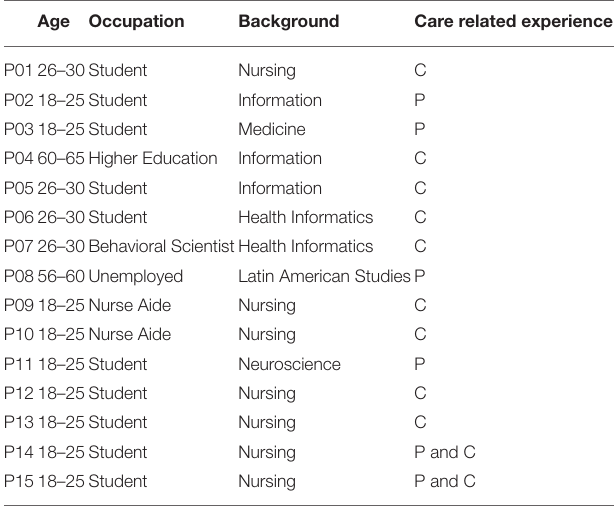
high school degree or equivalent (3), bachelor or some college education (7) and masters